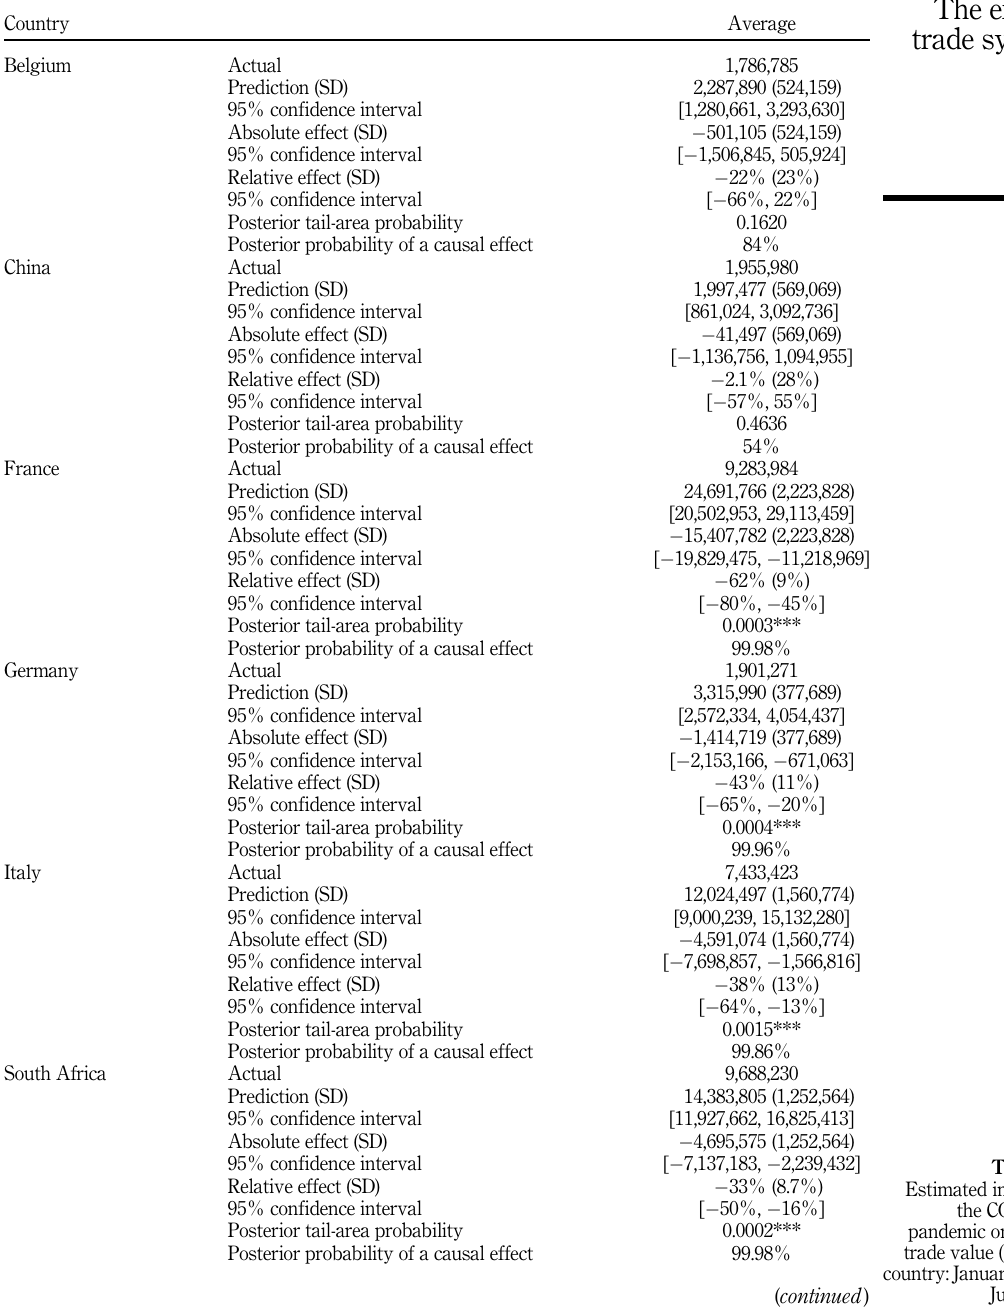
Table 5. Estimated impact